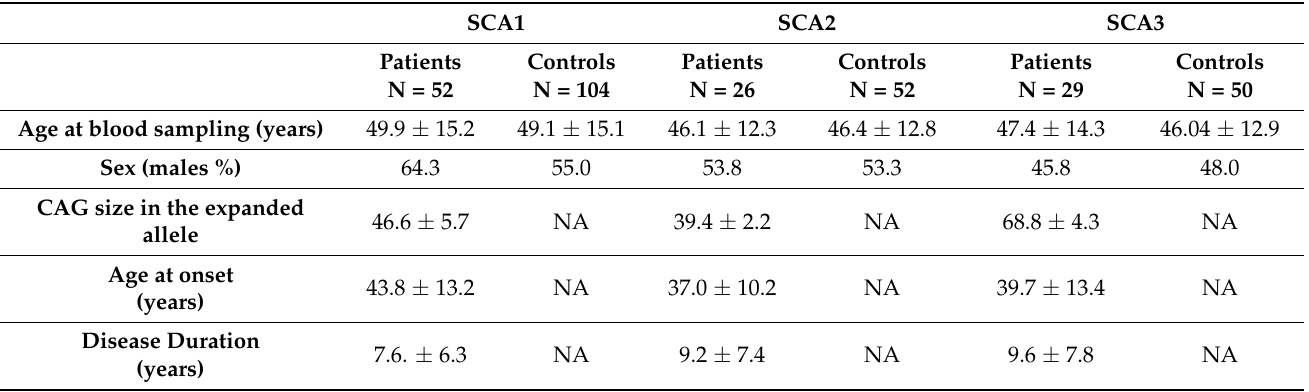
Table 1. Demographic, genetic and clinical characteristics of SCA1, SCA2, and SCA3 patients and controls. For each patient, two age- and sex-matching controls were included in the study. Data are shown as mean ± standard deviation; NA: not applicable. SCA1 SCA2 SCA3 Patients N = 52 N =